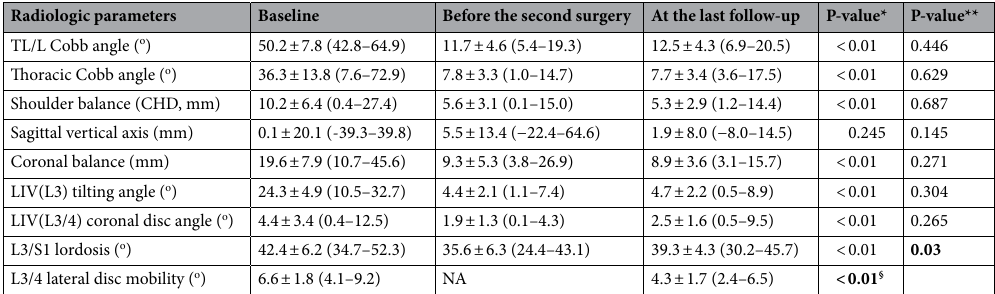
Table 2. Comparison of radiographic measurements from baseline, before the second surgery, and at the last follow-up after the second surgery. Data are presented as Mean ± SD/SE (Range). *: p-value from paired t-test comparing values at baseline with those before the second surgery. **: p-value from paired t-test comparing values before the second surgery with those at the last follow-up. § : p-value from paired t-test comparing values at baseline with those at the last follow-up. NA; not accessible. TL/L: Thoracolumbar/lumbar; CHD: Coracoid head difference.